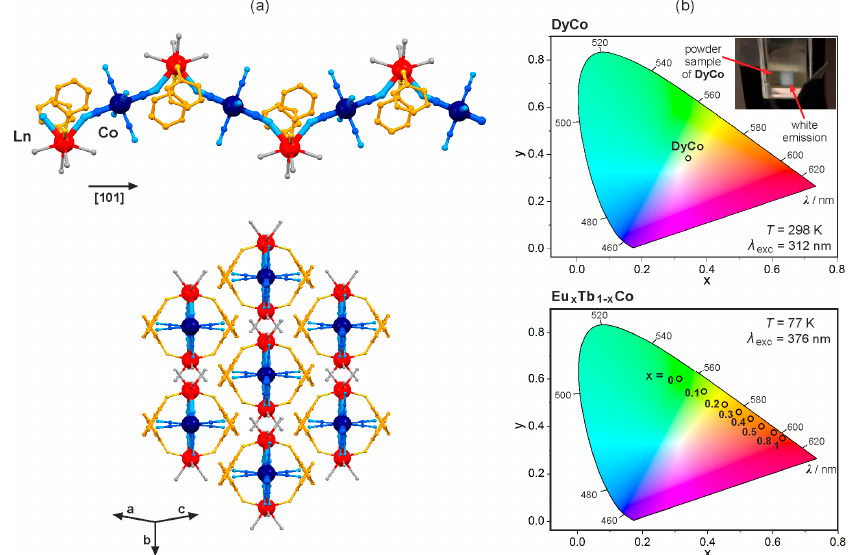
Figure 5. Crystal structure and optical properties of [Ln III (3-OHpy) 2 (H 2 O) 4 ][Co III (CN) 6 ]·H 2 O (Ln = Eu, Tb, Dy; 3-OHpy = 3-hydroxypyridine) cyanido-bridged chains: ( a ) the views of the coordination chain, and the arrangement of chains; ( b ) the white light emission of DyCo chains and the related photo (top), the multi-coloured composition-dependent emission of Eu x Tb 1- Co (bottom), all shown on the CIE 1931 chromaticity diagram. Colours for the structural diagram: Ln, red; W, dark blue; CN − , blue; 3-OHpy, orange; H 2 O, grey [96,97].